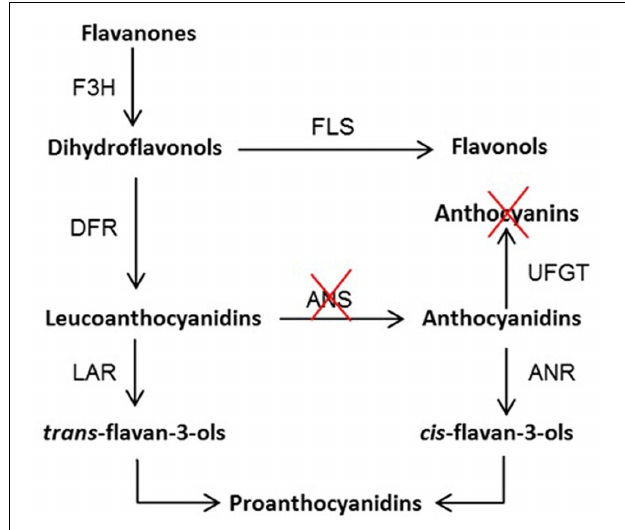
FIGURE 6 | Proposed flavonoid biosynthesis pathway in raspberry. F3H, flavanone 3 β -hydroxylase; DFR, dihydroflavonol 4-reductase; ANS, anthocyanidin synthase; UFGT, UDPG-flavonoid-glycosyltransferase; ANR, anthocyanidin reductase; LAR, leucoanthocyanidin reductase; and FLS, flavonol synthase. The red crosses indicate the blocked step of anthocyanin biosynthetic pathway at ANS level leading to the absence of anthocyanin